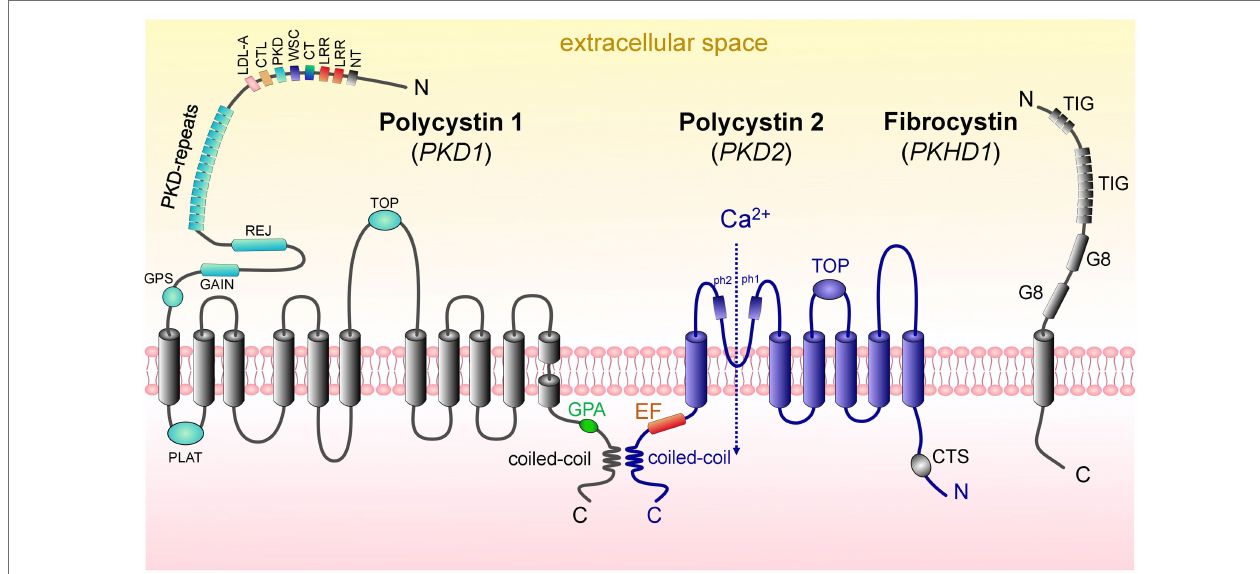
FIGURE 2 | Domain structure of proteins causing ARPKD and ADPKD: polycystin 1, polycystin 2, and fibrocystin. ( left ) PC1 contains 11 transmembrane domains (TD); in addition, there are the following domains: PC1 lipoxygenase α -toxin (PLAT) domain, tetragonal opening for polycystins domain (TOP), an intracellular C-terminus with a coiled-coil domain and a G-protein activating site (GPA), an extracellular N-terminus with a G-protein site (GPS), a G protein-coupled receptors autoproteolysis-inducing (GAIN) domain, receptor for egg jelly (REJ), PKD-related repeats, low-density lipoprotein-A domain (LDL-A), C-type lectin domain (CTL), cell wall integrity and stress component domain (WSC), C-terminal cysteine-rich domain (CT), leucine-rich repeat (LRR), and N-terminal cysteine-rich domain (NT). ( middle ) PC2 has 6 TD, a tetragonal opening for polycystins domain (TOP) and two pore helices (ph1 and ph2); both of its C-and N-termini are cytosolic. Of note, its C-terminus contains an EF-hand domain and a coiled-coil domain, and in the N-tail contains a ciliary targeting sequence (CTS). PC1 and PC2 can interact via their coiled-coil domains. ( right ) FPC contains 1 TD, a short cytosolic C-tail, and a long extracellular N-terminus. The N-terminus contains two G8 domains, which can be involved in ligand binding and catalysis, and multiple copies of an Ig-like domain (TIG). Abbreviations : Polycystin 1 (PC1), polycystin 2 (PC2), transmembrane domain (TD), fibrocystin